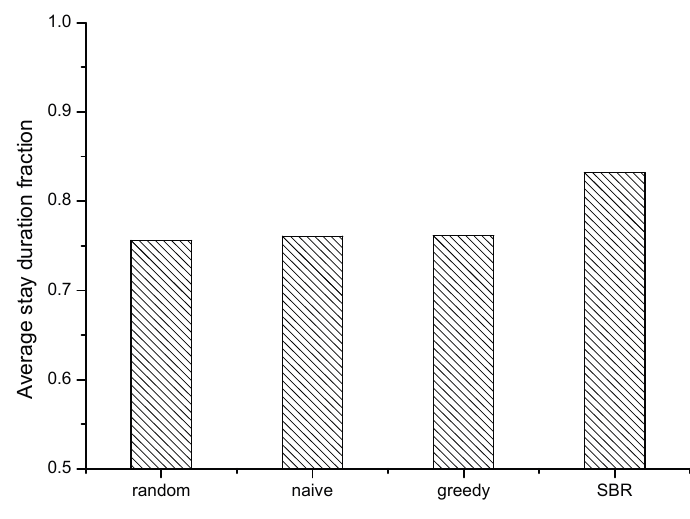
Figure 3. The number of participants with different recruitment schemes.